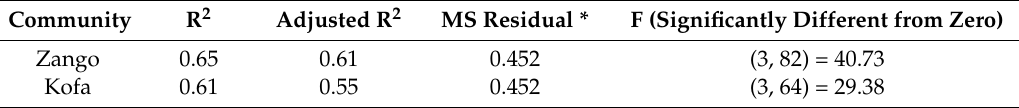
Table 5. Regression model for Zango and Kofa communities for climate change adaptation intention.